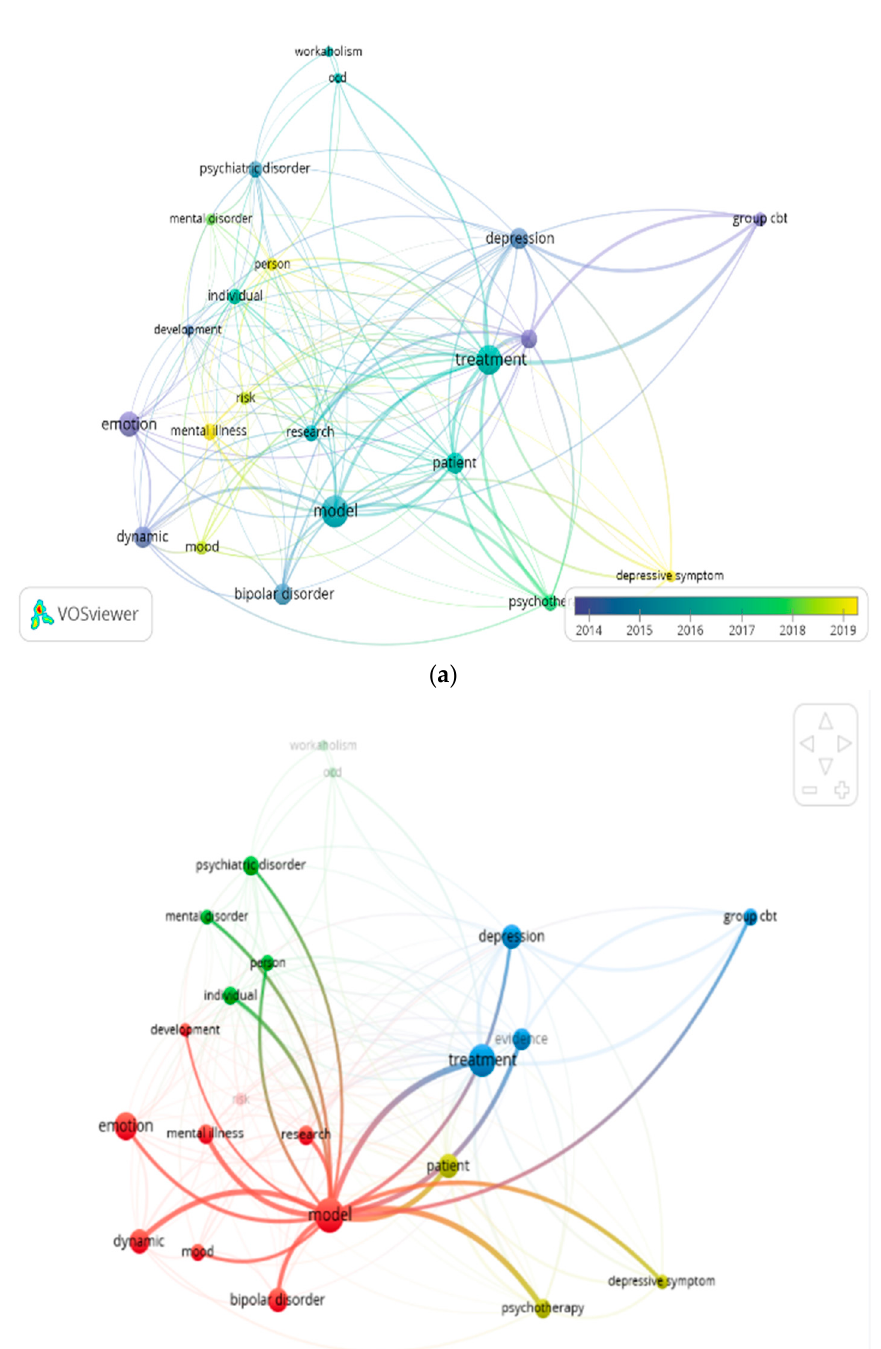
Figure 2. ( a ) Visualization of the article database: The aggregated network graph of the article database. ( b ) The network graph grouping the keyword “model” with other keywords from the article